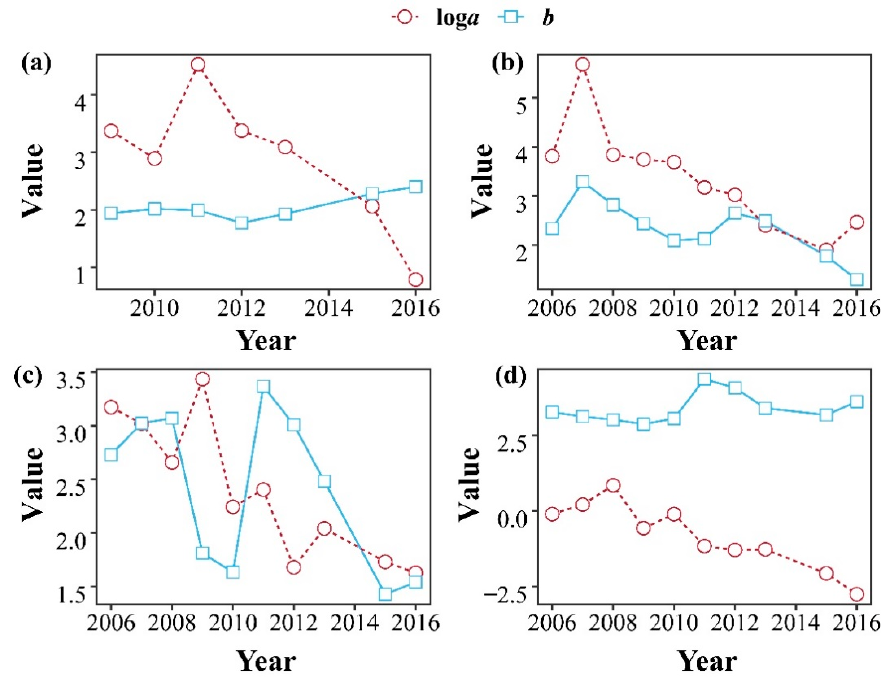
Figure 8. Trends in the parameters a and b of SRCs for four hydrological stations: ( a ) YZ, ( b ) HB, ( c ) HFW, and ( d ) QYS.